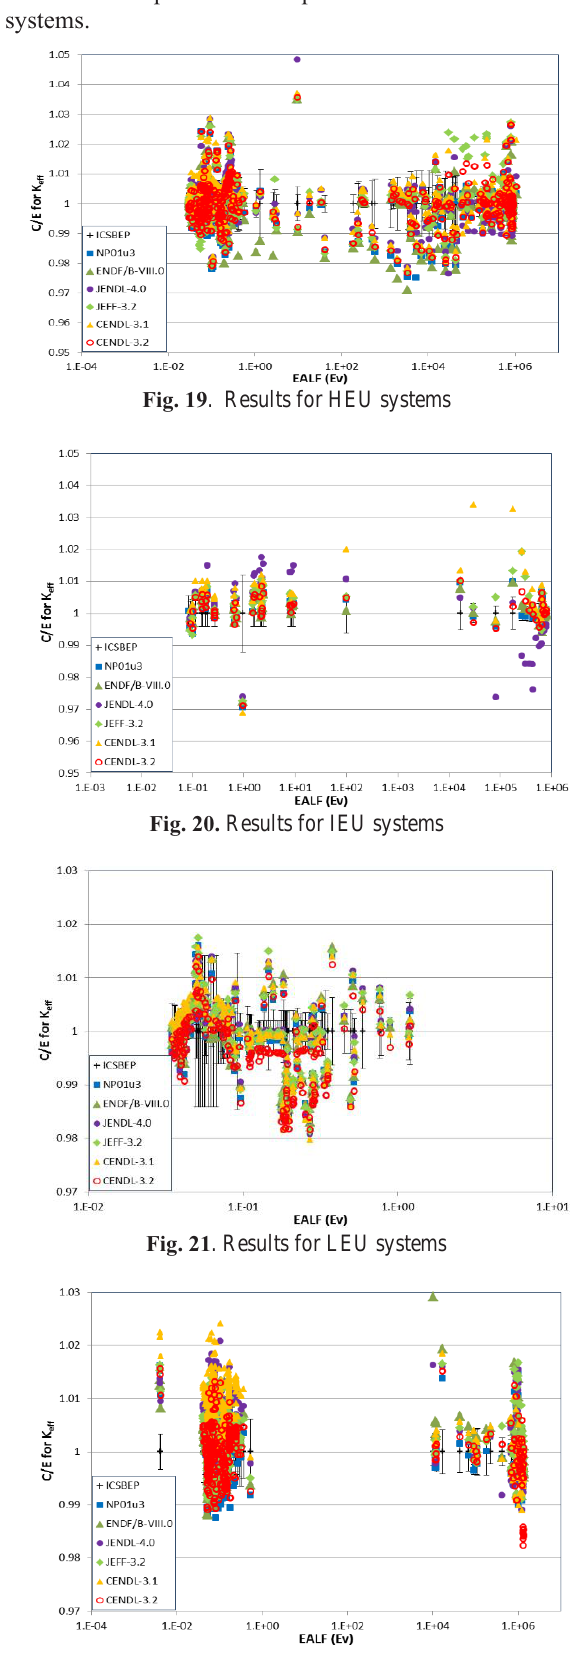
Fig. 22 . Results for Pu